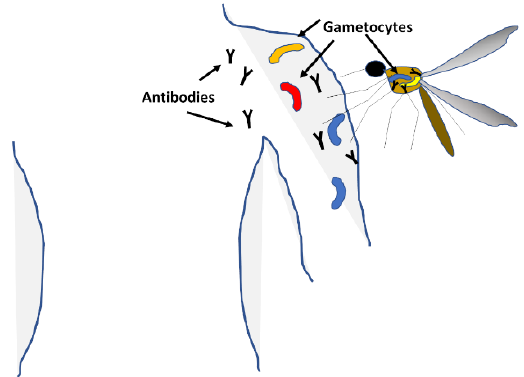
Figure 4. Transmission. Male and female gametocytes form in the blood stream and migrate to the skin, where they are taken up by feeding mosquitoes. Transmission-blocking vaccines aim to mount an immune response against the gametocytes or the early development stages in the mosquito to eliminate the sexual stages and reduce the oocyte load in the vector.